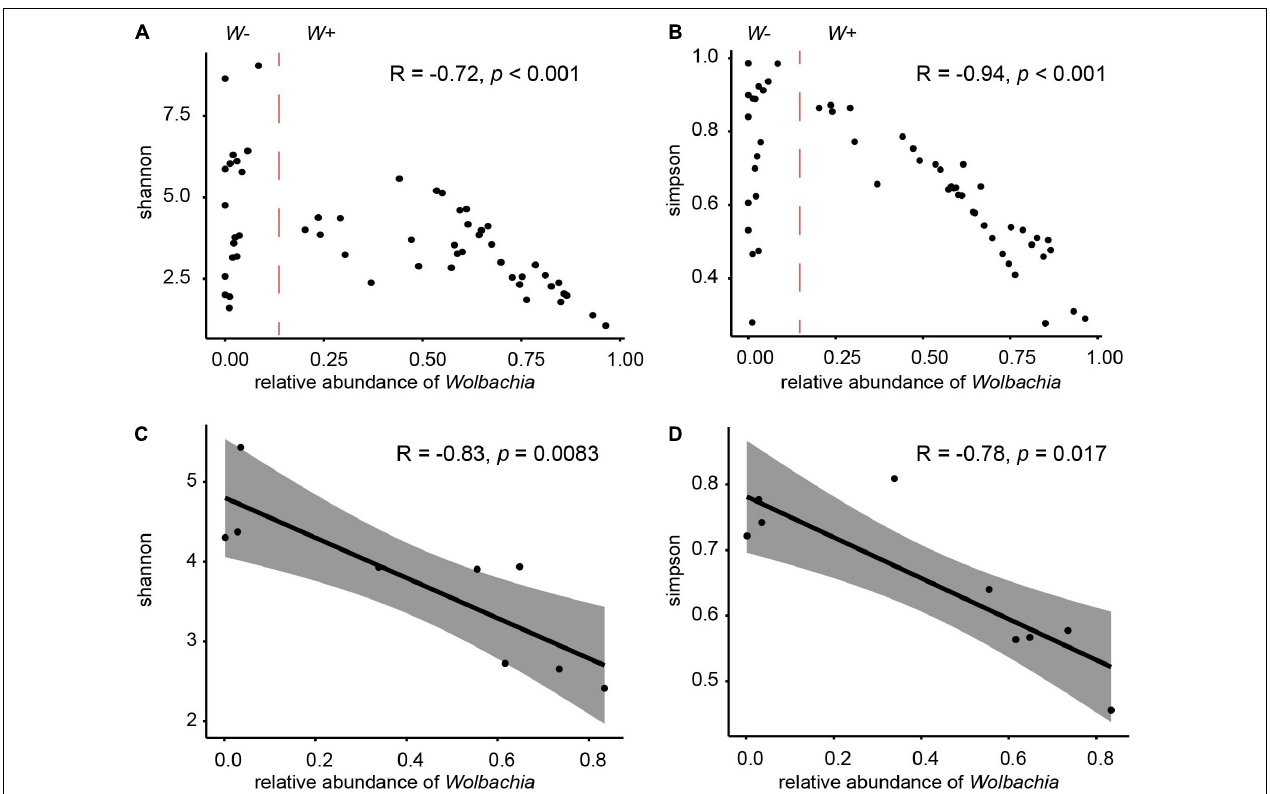
FIGURE 5 | Effects of Wolbachia on the microbial communities. Relationships between the proportions of Wolbachia and the Shannon indices (A) and Simpson indices (B) of microbial community in samples from group W +. Relationships between the proportions of Wolbachia and the Shannon indices (C) or Simpson indices (D) of microbial community in nine populations. R values and P -values of Spearman’s rank correlation are